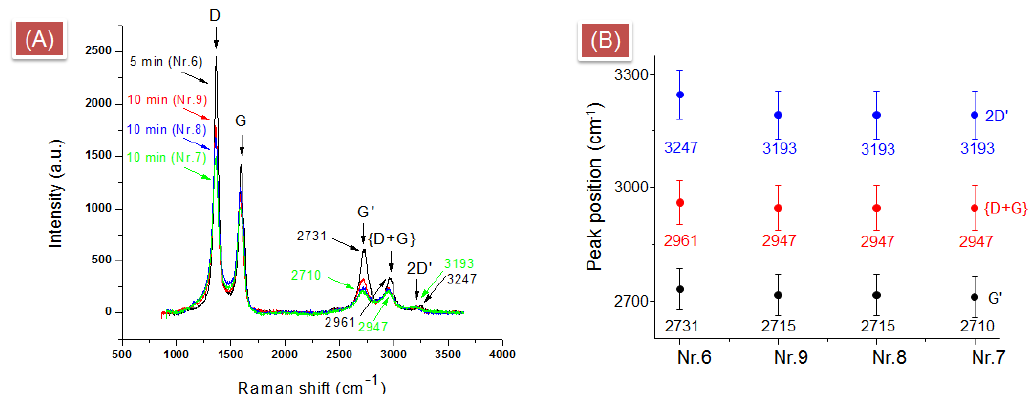
Figure 7. ( A ) Averaged Raman spectra of VOG Samples 6–9 and ( B ) peak positions of G', {D+G} and 2D' Raman secondary order modes of these samples.